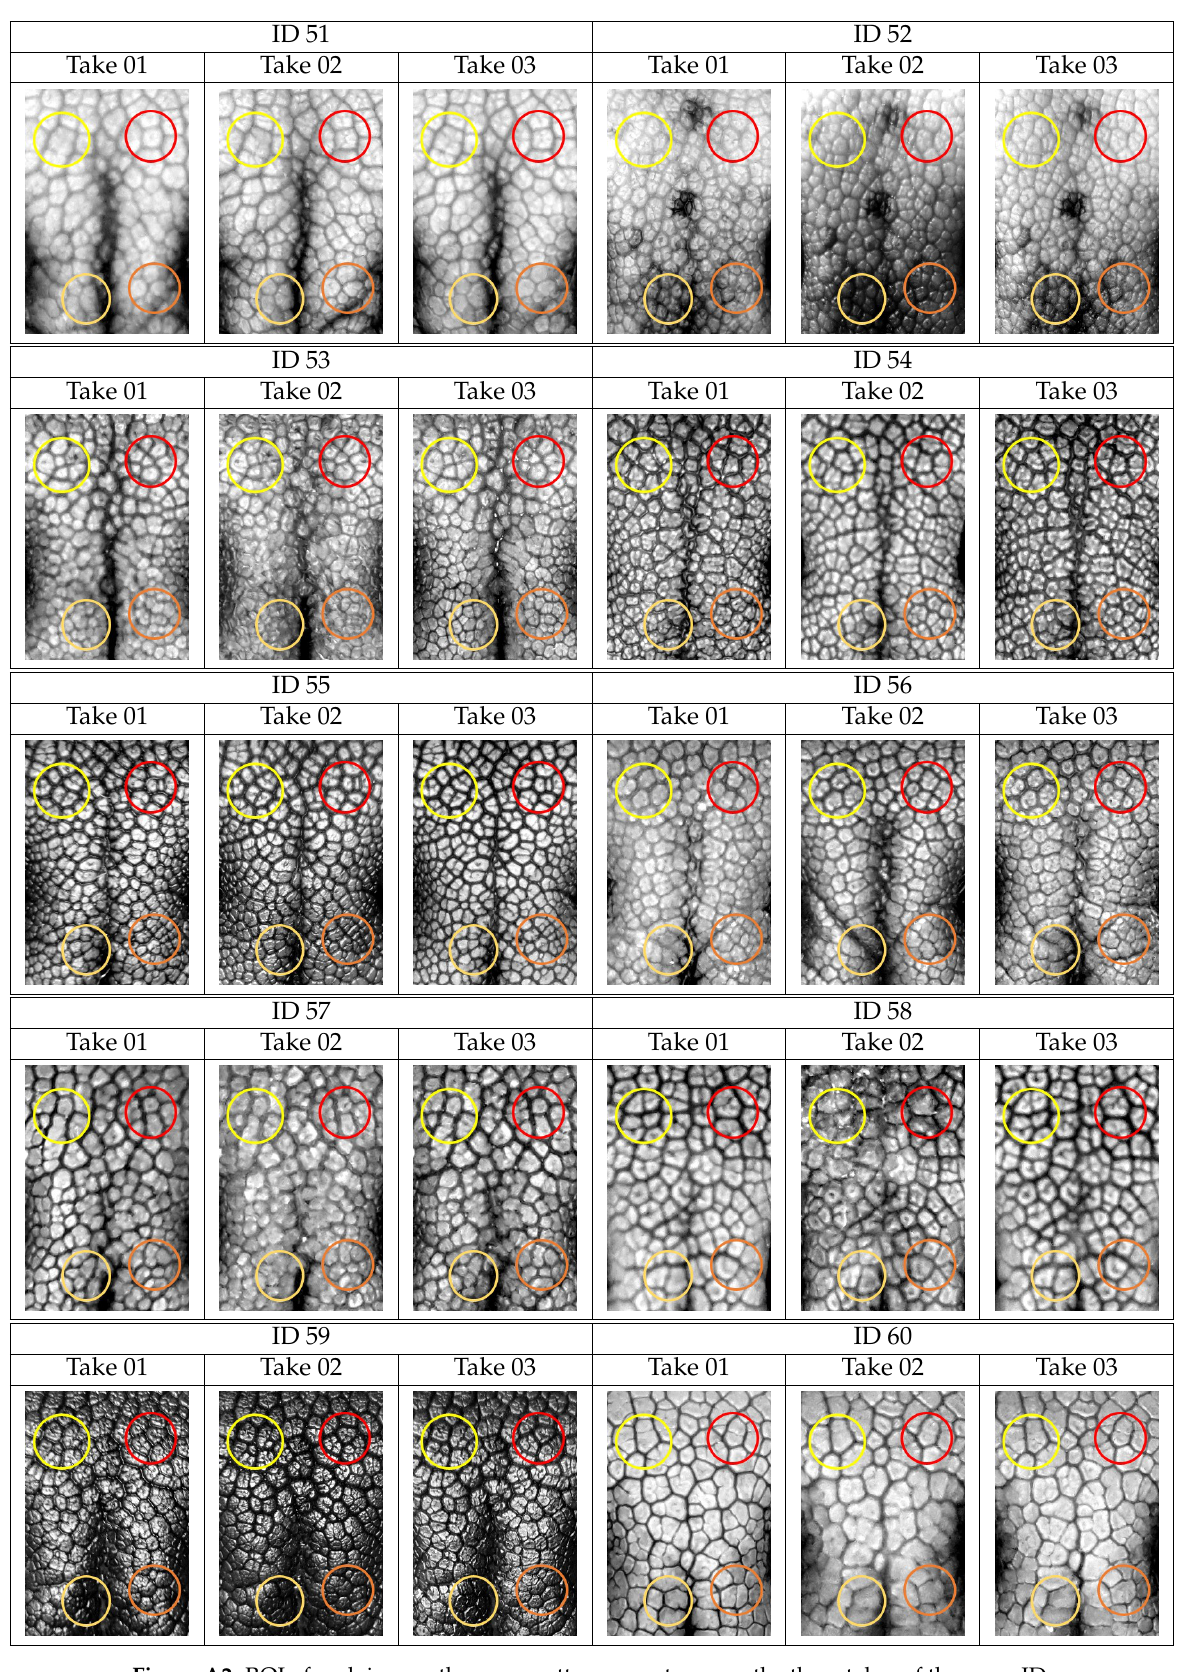
Figure A2. ROI of each image; the same pattern repeats across the three takes of the same